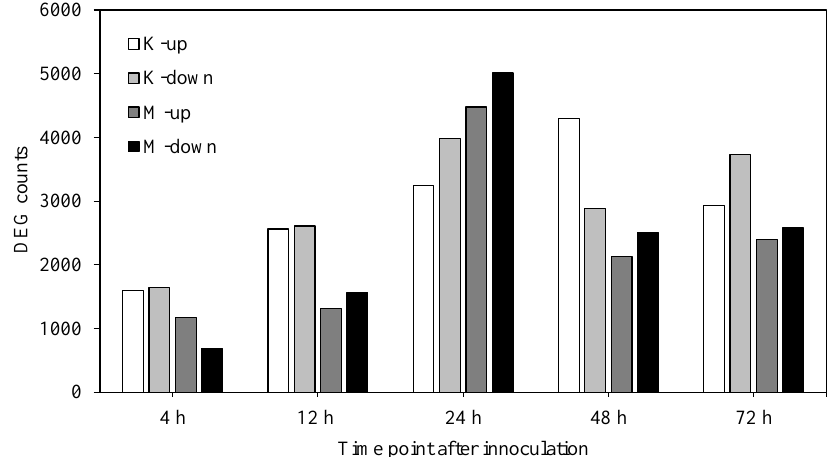
Figure 3. The number of DEGs produced at 5 time points after inoculation with the control (0 h). K-up: upregulated genes in HZ2399; K-down: downregulated genes in HZ2399; M-up: upregulated genes in SQ25; M-down: downregulated genes in SQ25.